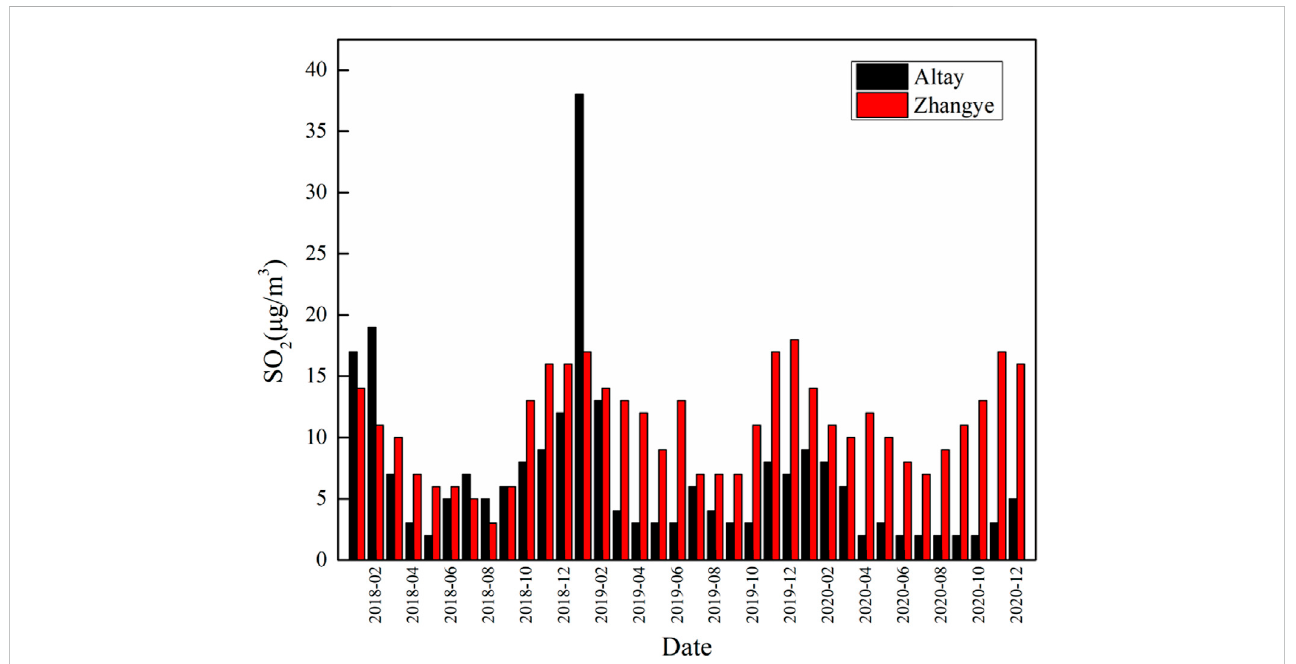
FIGURE 9 Monthly average value of SO 2 concentration in the atmosphere of Altay and Zhangye regions from 2018 to 2020. Among them, Zhangye is selected as the meteorological station near the Heihe sampling point. The data come from the China Meteorological Administration (http://data.cma.cn/).